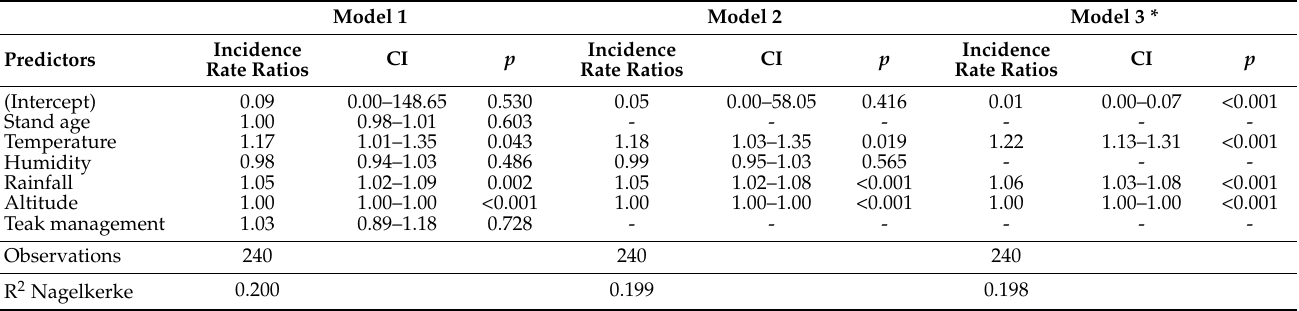
Table 4. Generalized linear models relating species richness of ambrosia beetles to stand age, altitude, temperature, rainfall, humidity, and teak